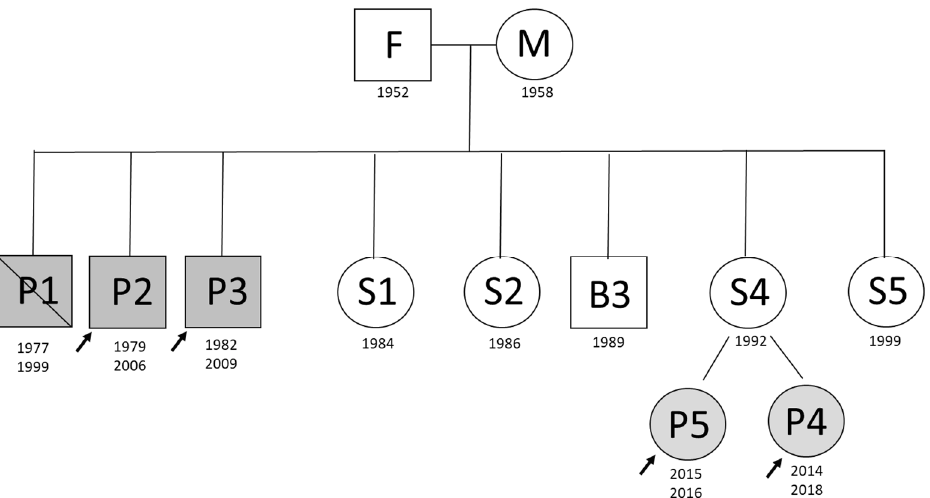
Figure 1. Pedigree of the aHUS-affected family. The deceased individual (P1) is depicted with diagonal line through it. Under each individual, the year of birth and, if appropriate, the individual’s year of disease onset appear. Black colored shapes indicate aHUS patients. The patients described in the study are marked with arrows. The lettering indicates parents of the family: father (F), mother (M) and siblings as further referred to in the text and tables; B-brother, S-sister; P stands for the patients (probands) enrolled in this study.